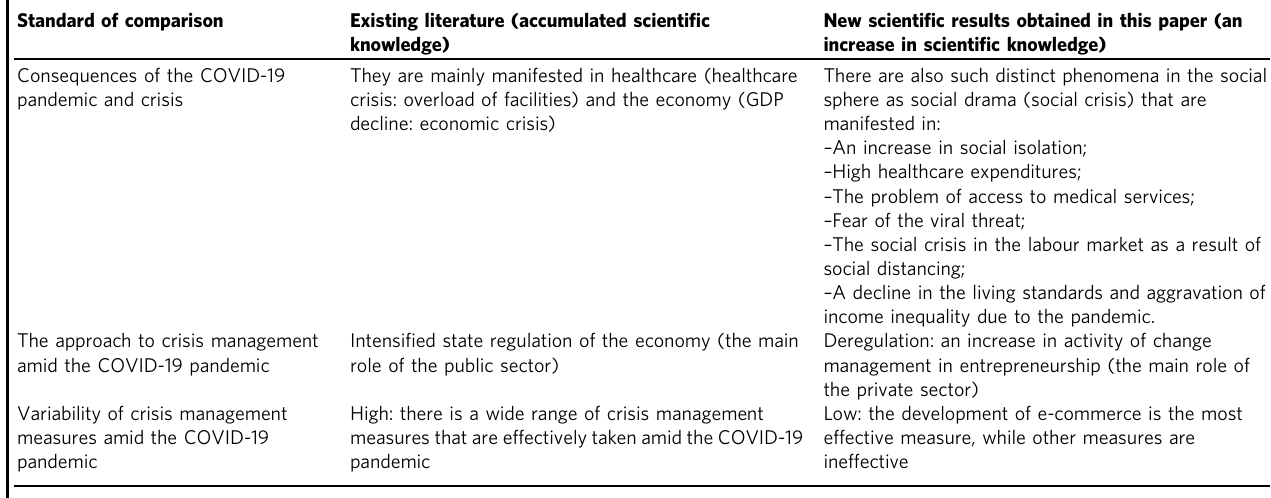
Table 8 Comparative analysis of new scienti fi c fi